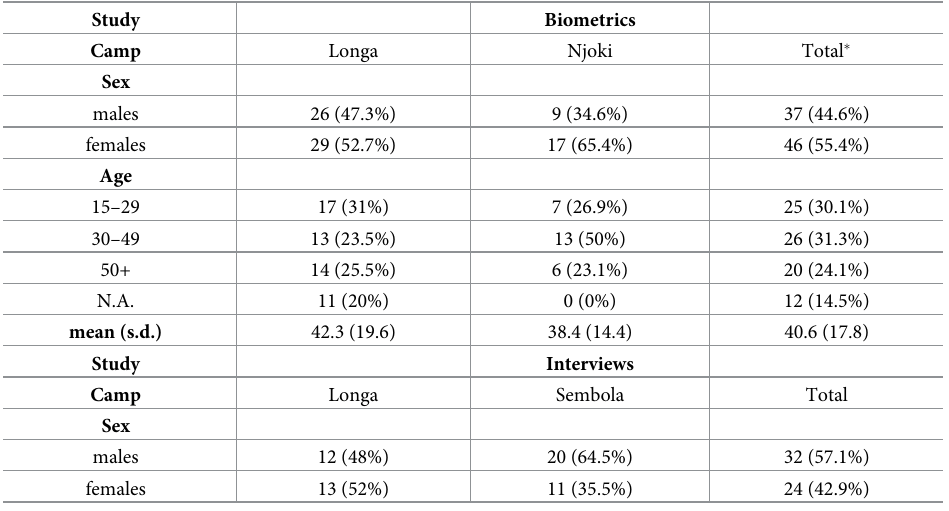
Table 2. Sample characteristics for quantitative analyses and structured interviews.